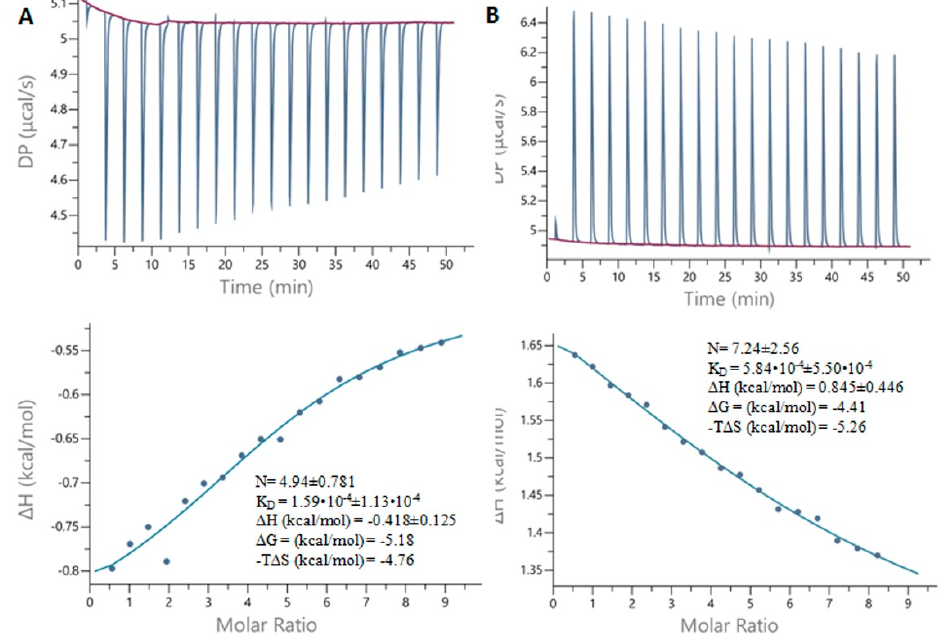
Figure 8. The results of ITC measurements of ( A ) D-(–)-quinic acid–BSA; ( B ) D-sorbitol–BSA.